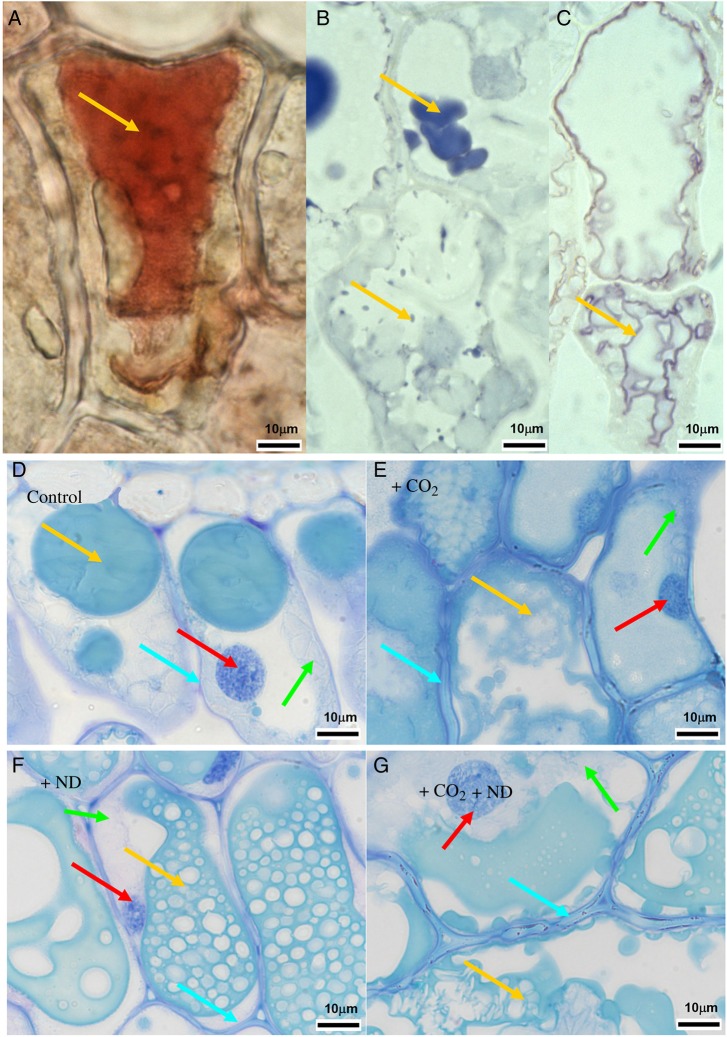
Histochemical detection of PCs in mesophyll cells of current-year spruce needles using vanillin (A) and DMACA (B and C) reagents. Procanthocyanidin oligomers (staining red in A) were mostly soluble in the vacuolar medium. PC polymers (staining bluish in B and C) were precipitated as phenolic bodies of varying size and shape such as globules (B) or fine ribbons bordering the tonoplast (C). Structural effects of +CO2 (E), +ND (F) and +CO2 + ND (G) versus control (D) in mesophyll cells from samples harvested in January (staining with toluidine blue). There were no starch grains in chloroplasts (green arrows), whatever the treatment, since this relates to a typical winter dormancy effect. Under +CO2, cell walls (cyan arrows) were thickened (E, G versus D), the frequency of chloroplasts (green arrows) reduced (E, G versus D, F) and the amounts of condensed tannins (yellow arrows) increased (E, G versus D), with most of cell lumen filled up. Specific to the +CO2 treatment (E), vacuoles were enlarged and had an irregular shape whereas the cytoplasm and nucleus (red arrows) showed increased condensation. In response to +ND and as a tendency, nuclear chromatin appeared condensed and the amounts of condensed tannin increased (F versus D).